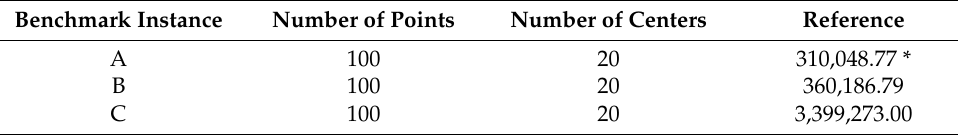
Figure 3. Benchmark instance C. Table 4. Benchmark instances—final